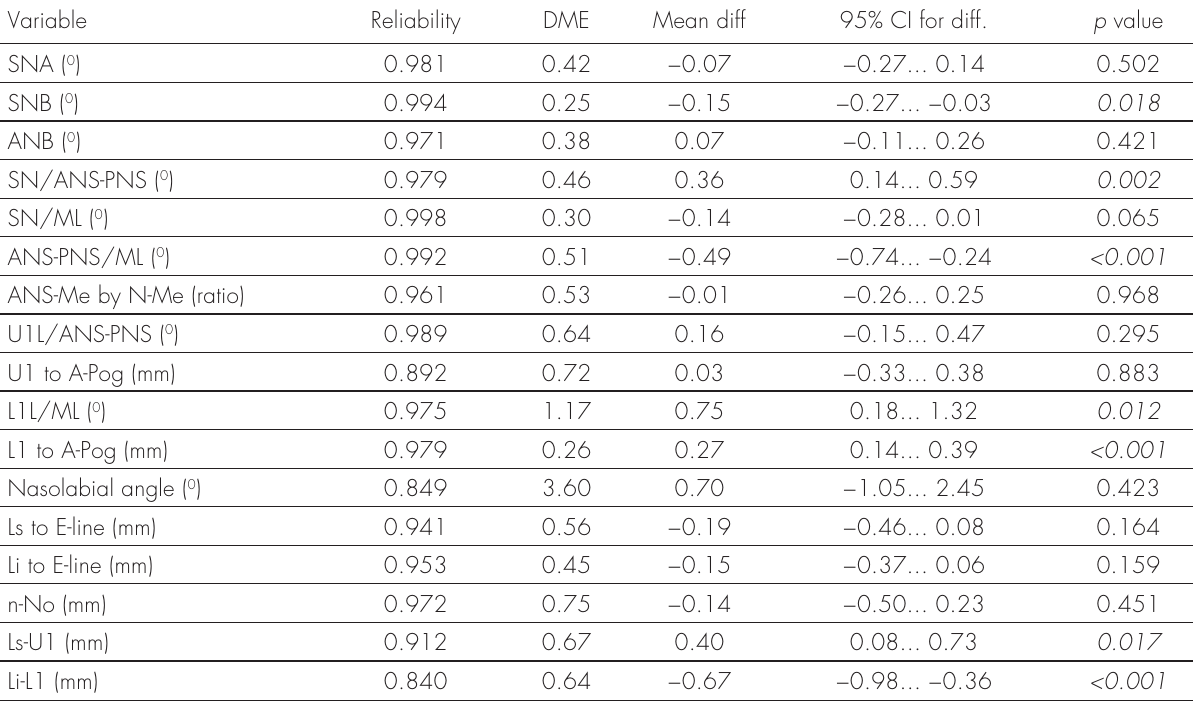
Table II. Intra-observer reliability and measurement error for the cephalometric values.